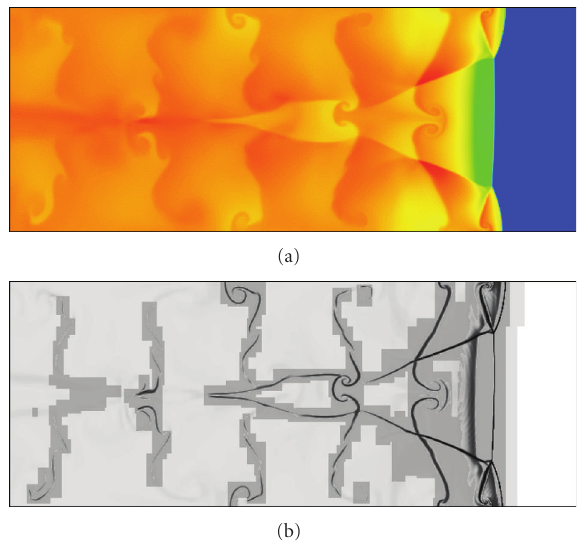
Figure 12: Color plots of temperature and schlieren plots of density on refinement in 2nd half of a detonation